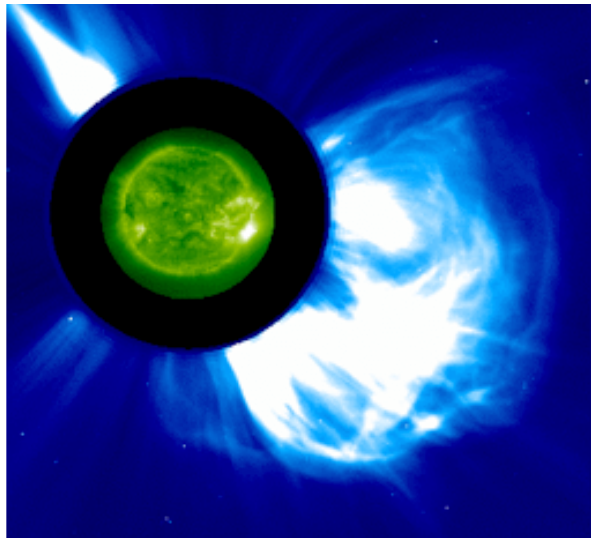
Fig. 1. CME on the 4th November 2003 (EIT: 20:00UT, LASCO/C2: 20:06UT). Illustrating the contradiction between small-scale source region (the bright flaring region on the West limb) and the large extent of the CME.